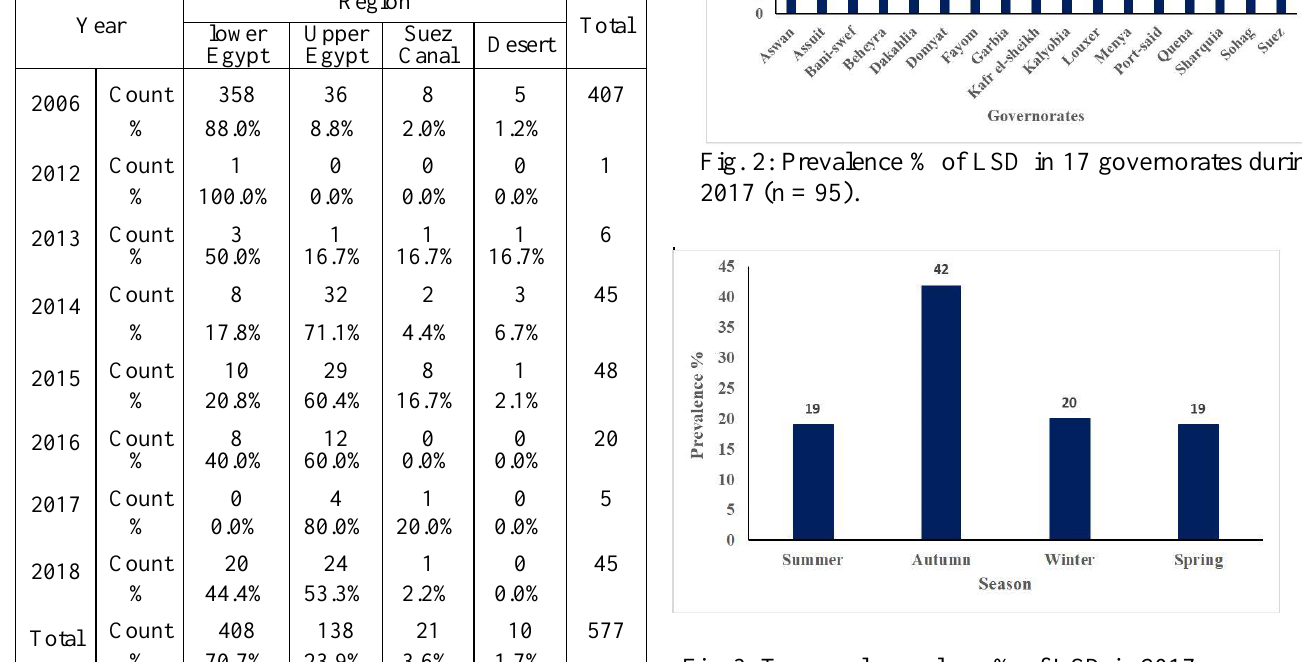
Fig. 3: Temporal prevalence% of LSD in 2017